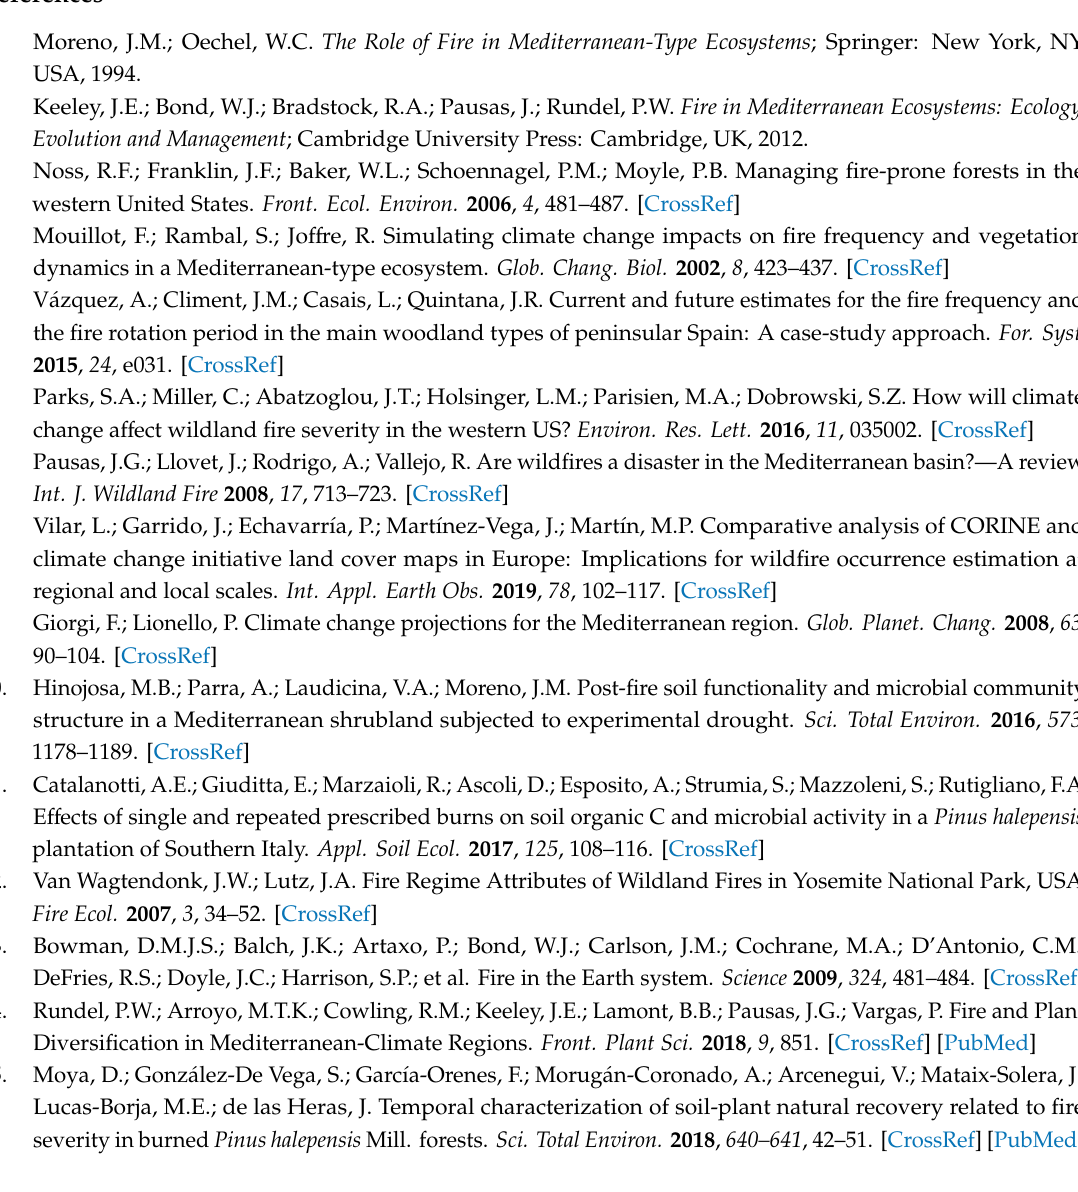
Table S1: Results of the fixed e ff ects of the Generalized Linear Mixed Models (GLMMs) [‘ summary ()’ outputs] in the three study sites (Mediterranean, Transition, and Oceanic), indicating the e ff ects of the variables fire frequency recurrence (number of fires) and burn severity (dNBR ranging from -2 to 2) on soil properties. Author Contributions: V.F.-G., E.M., and L.C. conceived and designed the experiment; V.F.-G. and E.M. analyzed the soil properties in the laboratory; O.R. and L.C. obtained the data of the vegetation in the field; V.F.-G. analyzed the data; V.F.-G., E.M., and L.C. wrote the paper; L.C. coordinated the study. All authors have read and agreed to the published version of the